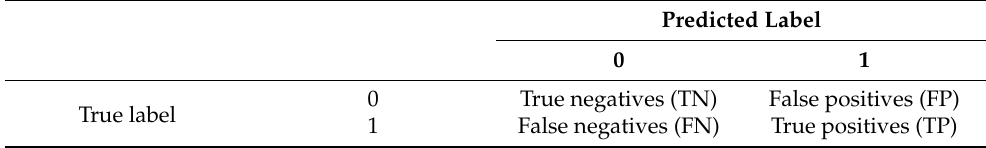
Table 4. Confusion matrix for binary